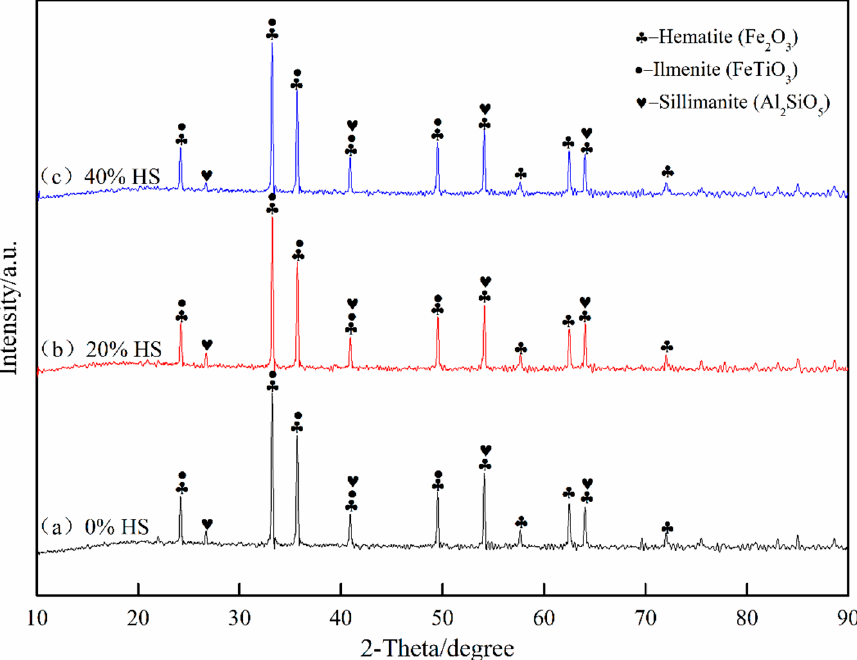
Minerals 2021 , 11 , x FOR PEER REVIEW Figure 5. Compressive strength of oxidized pellets with different the dosage of sea sand ore.